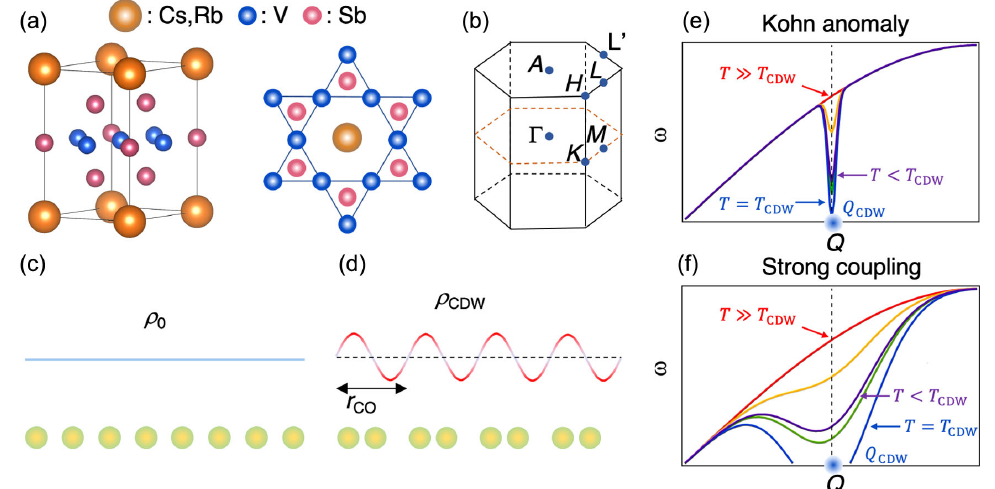
FIG. 1. The crystal structure of A V 3 Sb 5 and CDW-induced phonon anomalies. (a) shows the crystal structure of A V 3 Sb 5 (space group P 6 = mmm, no. 191), which consists of V-Sb slabs that are separated by alkali elements. The V-Sb slab contains a V-kagome lattice and two Sb sites laying in the kagome plane and above the V triangle. (b) shows the 3D BZ and high-symmetry points of A V 3 Sb 5 . (c) and (d) show the valence and core electron density in the normal and CDW phase, respectively. Because of EPC, the core electrons will follow the CDW period and yield acoustic phonon anomalies. (e) Nesting-induced Kohn anomalies. (f) Strong-coupling-induced phonon softening in an extended momentum space near Q . Red, yellow, green, blue, and purple colors represent temperatures from CDW T ≫ T to T < T . The phonon hardening for T < T is due to the CDW amplitude CDW CDW CDW